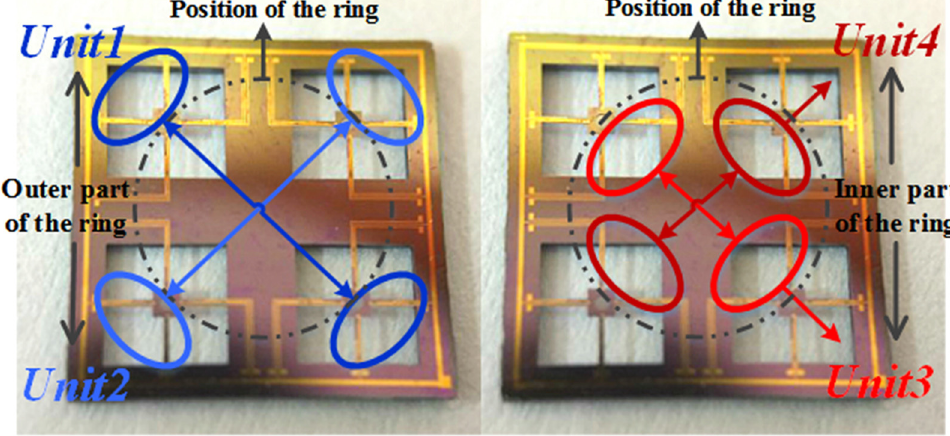
Fig. 10. New combination of AFUVH sensor